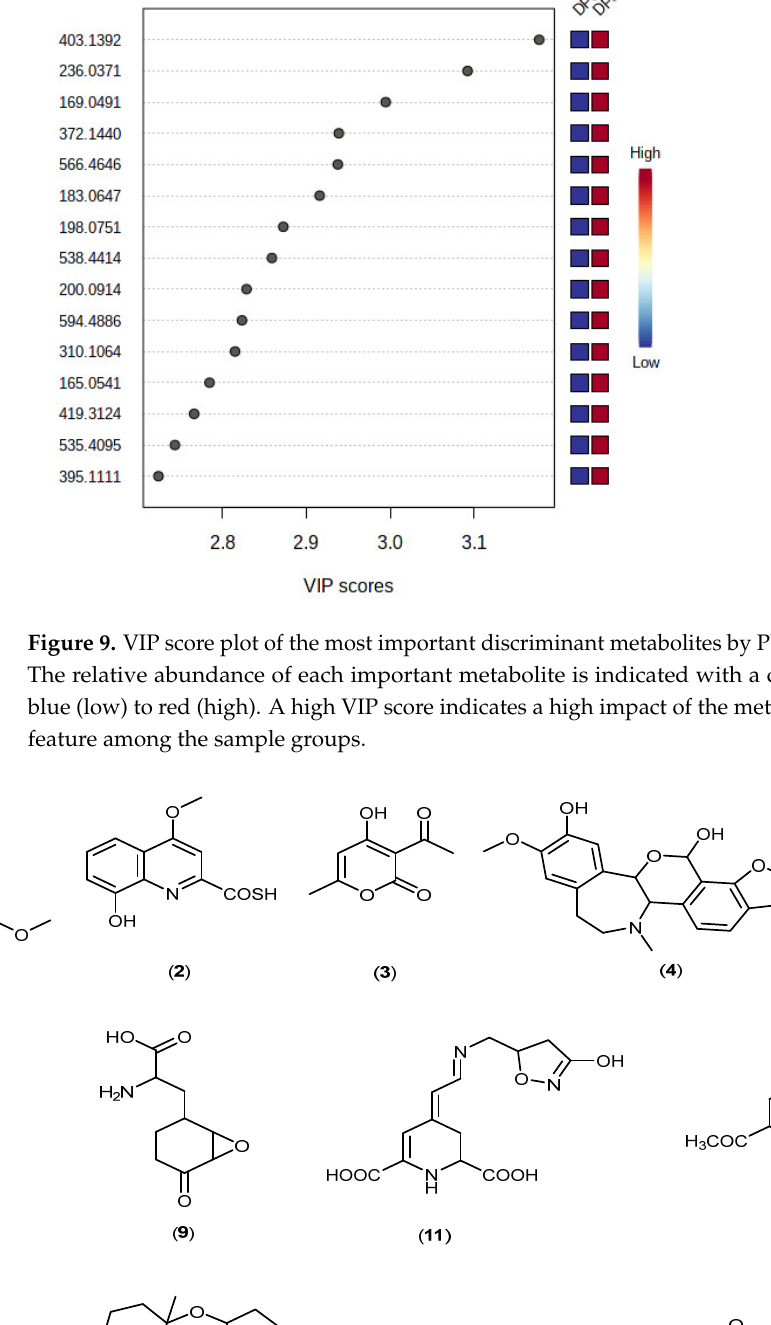
Figure 8. PLS-DA loading plot in supervised analysis obtained from DFC and DFS. Shown data are the Var ID (peak number). Table 2. Dereplication of discriminant putatively identified metabolites in DFC and DFS. The level of identification was L2—putatively identified metabolites through library matching [23].